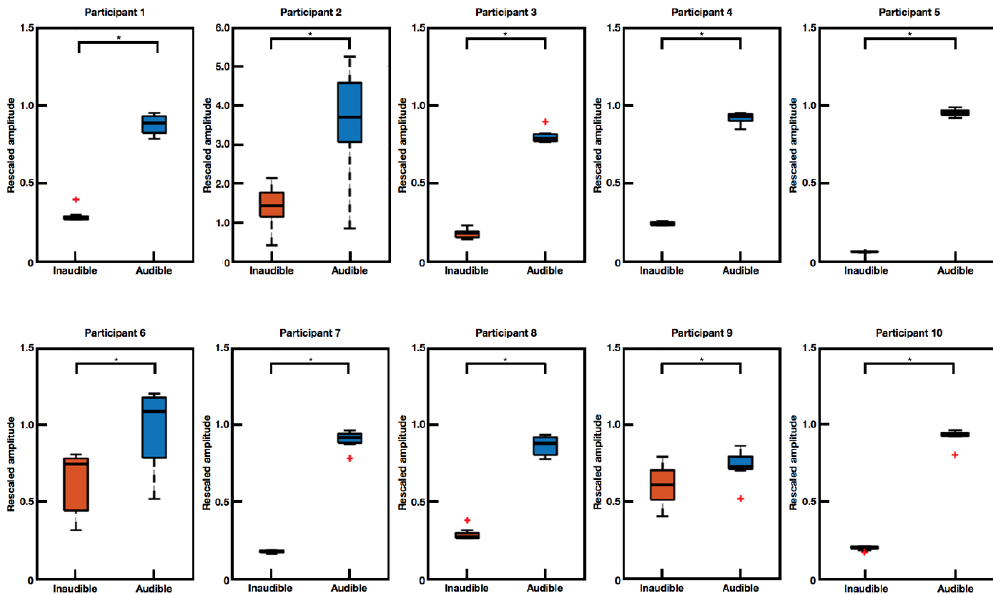
Figure 3. Box plots of rescaled (normalized) amplitudes for inaudible and audible conditions. Wilcoxon signed rank test showed a statistically significant difference between two conditions—inaudible and audible conditions—in all subjects (Bonferroni corrected p < 0.05, marked as *). Note that box plots for participant two have different scaling ranges.